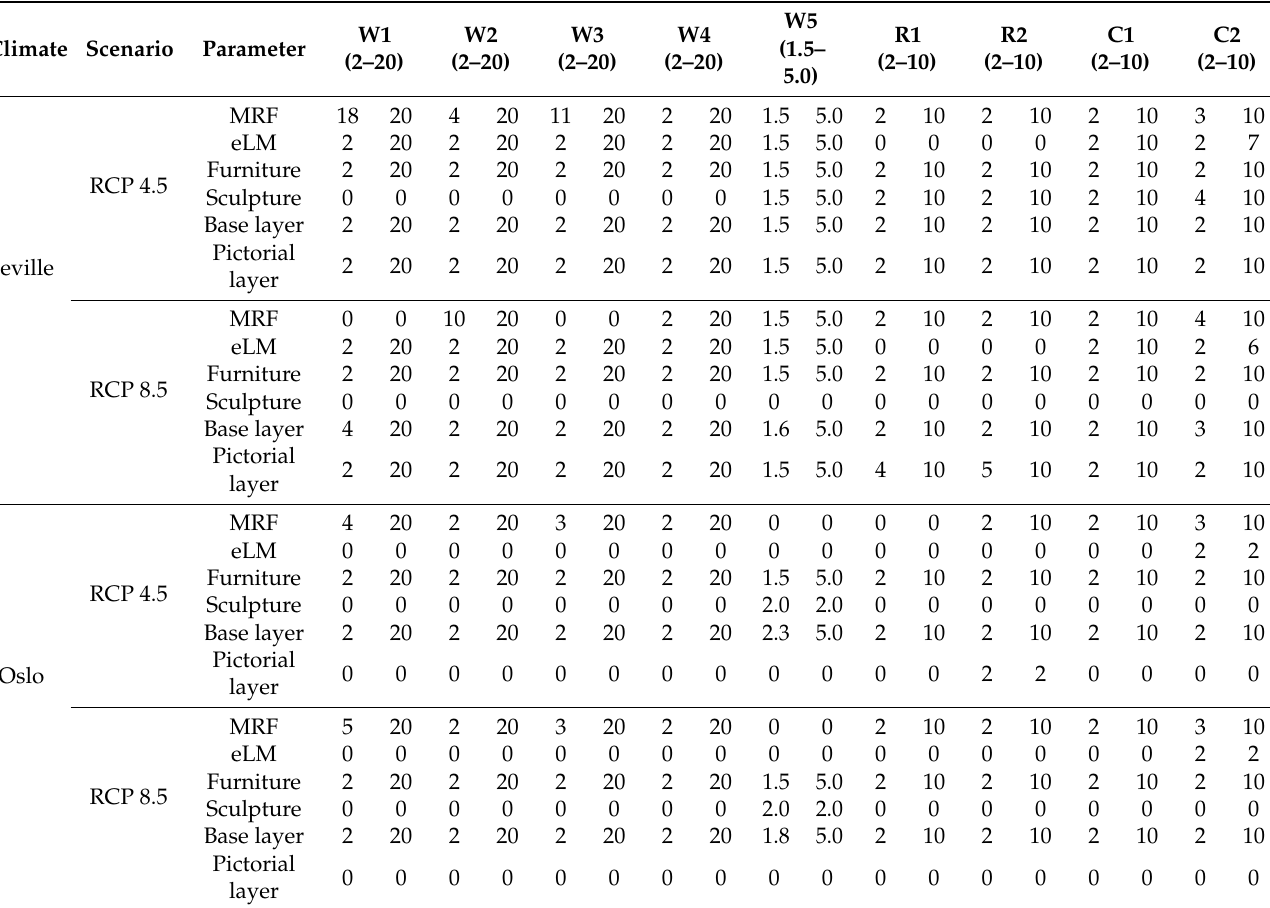
Table 2. Thickness range (cm) that outperforms the case study without any retrofit measure (WR) for Seville and Oslo for future conditions: RCP 4.5 and RCP